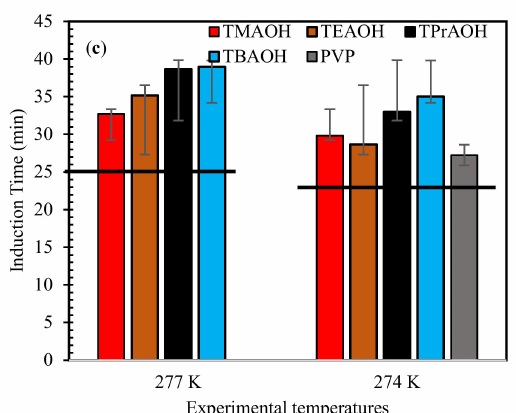
Figure 1. Influence of 1 wt% QAHs on induction times of mixed gas hydrates at different experimental temperatures for ( a ) 70% CH 4 + 30% CO 2 , ( b ) 50% CH 4 + 50% CO 2 , and ( c ) 70% CH 4 + 30% CO 2 , and comparison with the commercial inhibitor (PVP). The solid lines represent pure